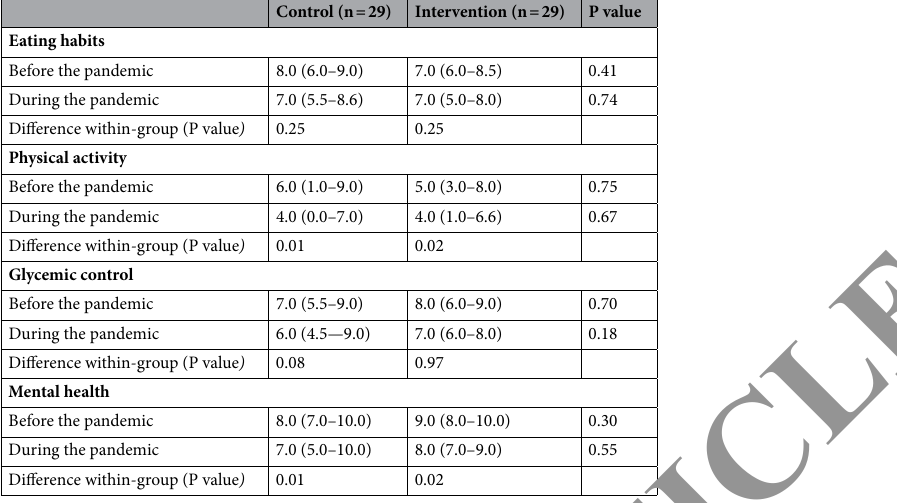
Table 3. Patients perceptions regarding changes in habits that occurred comparing the periods before and during the COVID-19 pandemic. Data are median and interquartile range (IQR) of the scores self-reported by the participants about the two evaluated periods. The participants were asked to give a score, from zero to 10, for the quality of the aspects presented in his daily routine before and during the COVID-19 pandemic. α ≤ 0.05 indicates significant